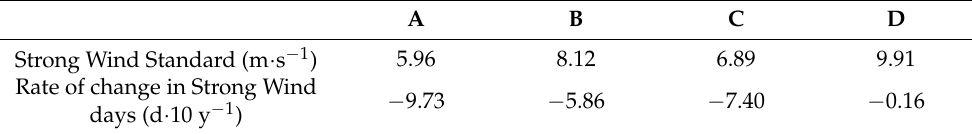
Table 1. Strong wind standard and the rate of change in strong wind days at stations A, B, C and